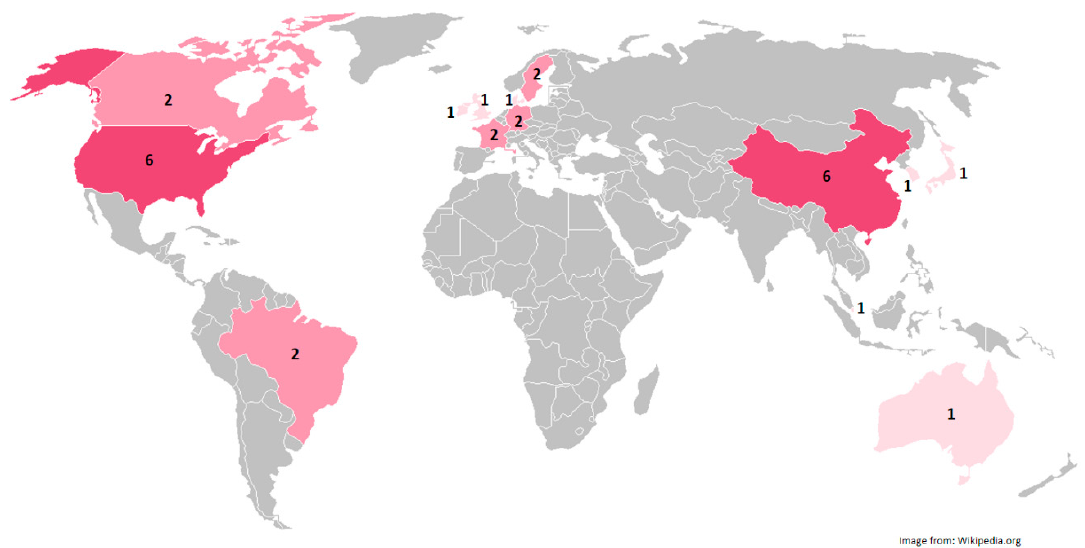
Figure 2. Number of published articles by each country. Four of the included articles were inter- institutional collaborations [34,36,38,49]. We counted these articles considering all collaborating countries; therefore, the sum of the articles is more than 24 in Figure 2.